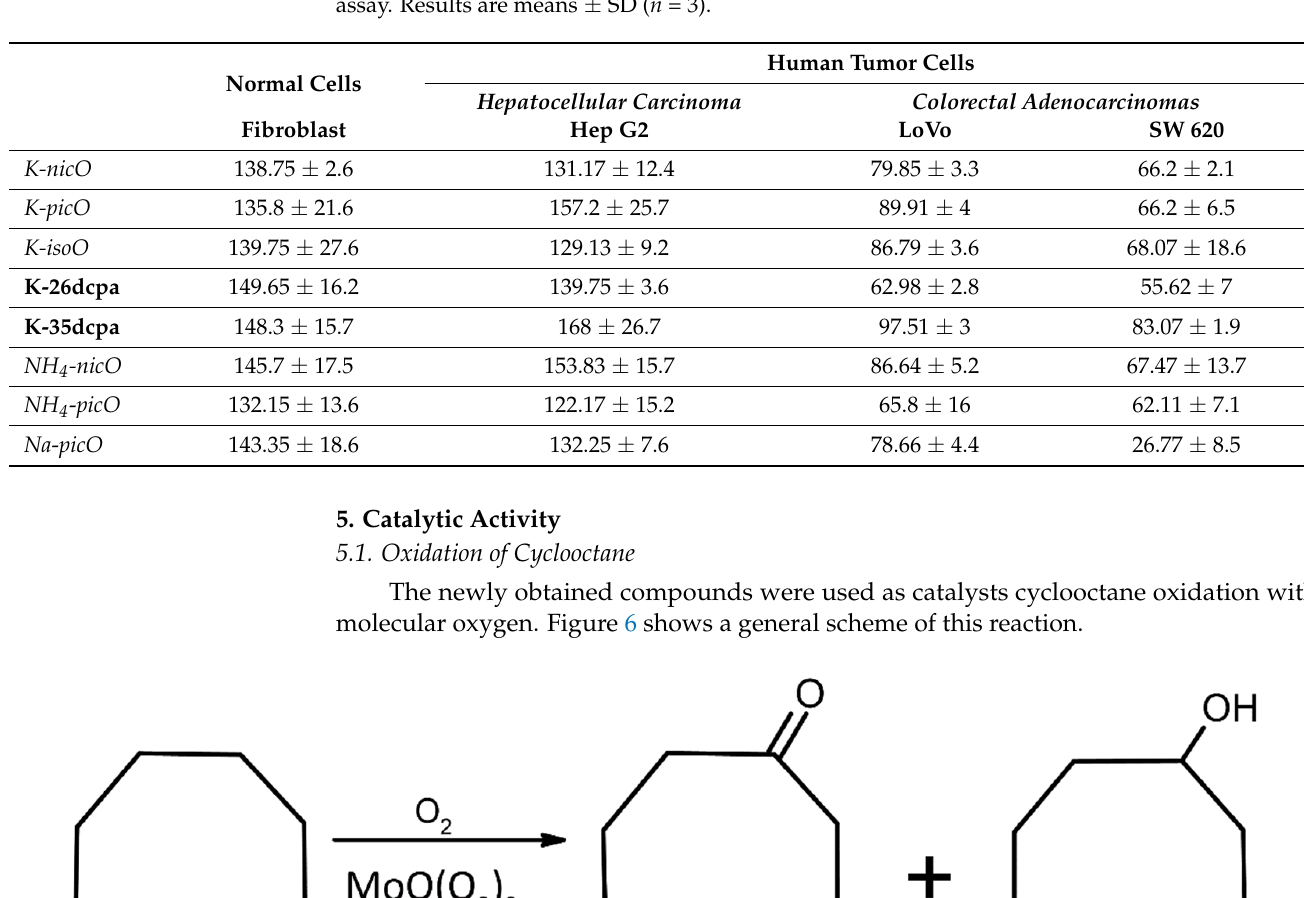
Table 6. Oxidation of cyclooctane using molybdenum complexes.